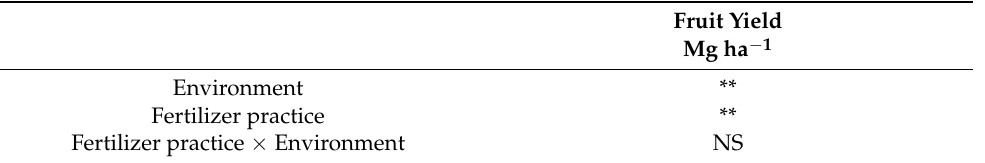
Table 3. Main effects and interaction effect for fruit yield determined for each factor: Environment and fertilizer practice. Mean values are reported. Within a column and within a given factor, means followed by the same letter are not statistically different (alpha = 0.1).